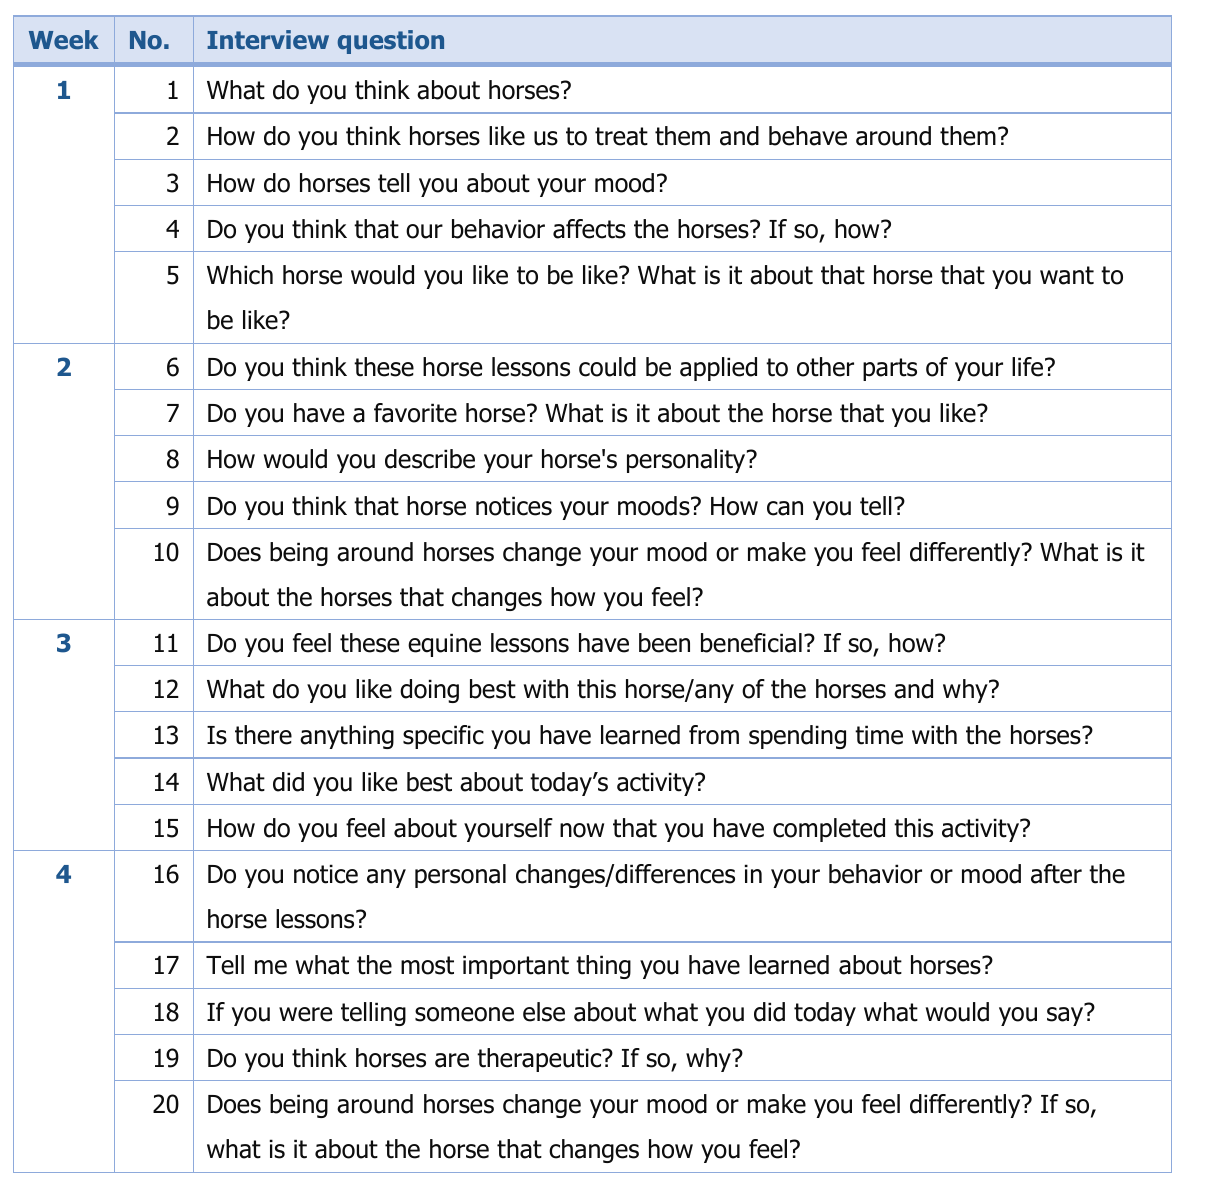
Table 3. Questions From the Participant